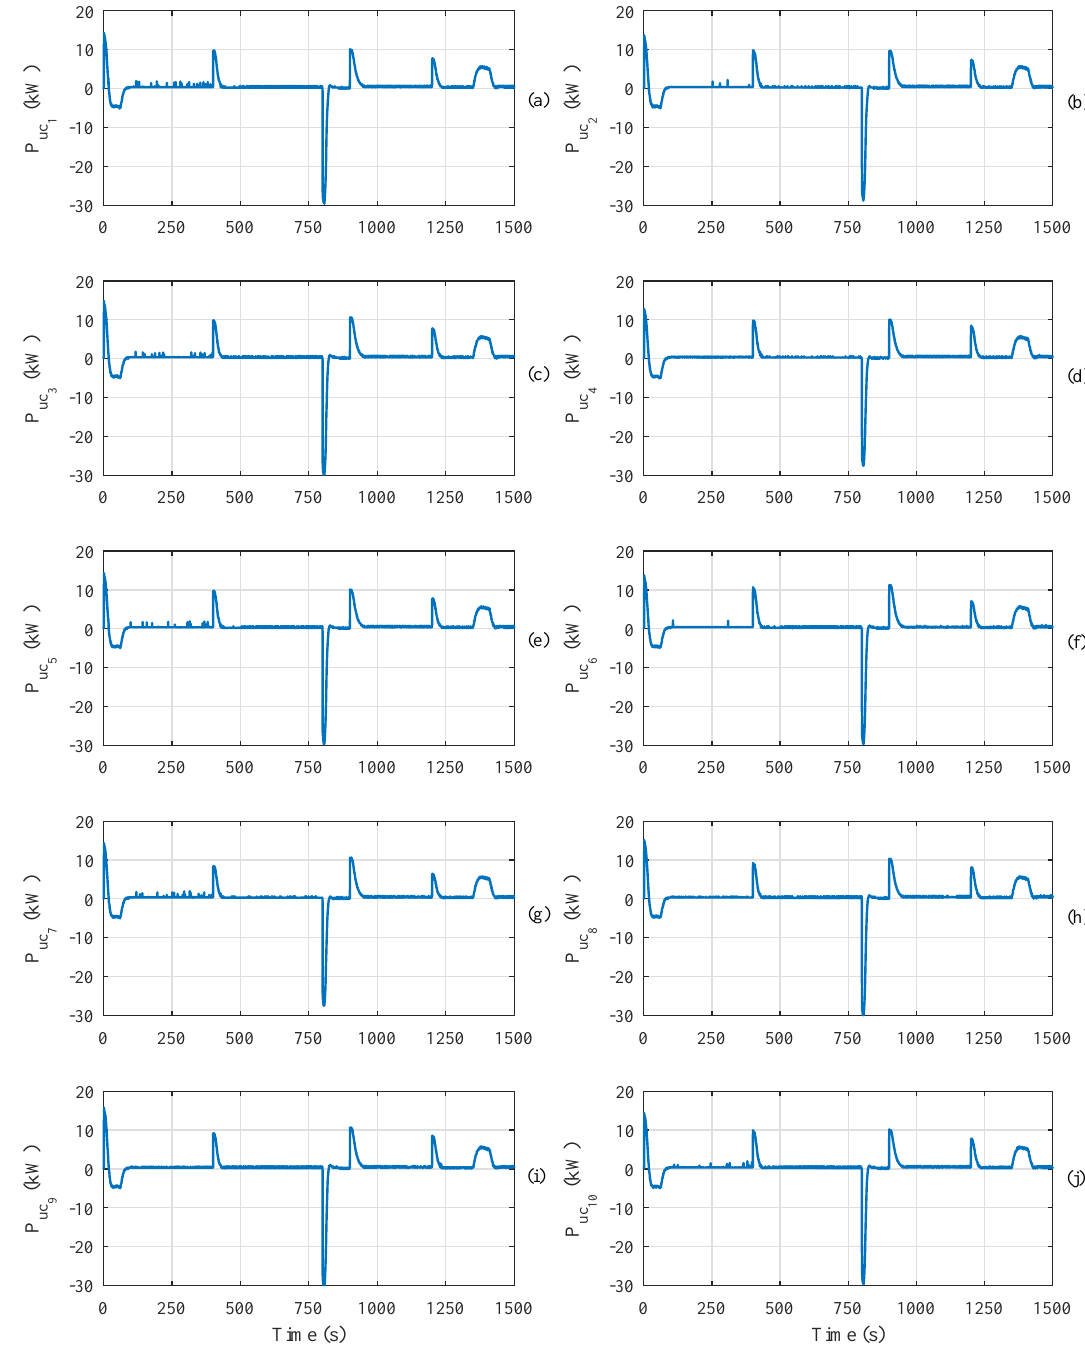
Figure 17. Powers generated/absorbed by the ultracapacitors of the 10 hybrid energy storage systems (HESSs). ( a ) p uc